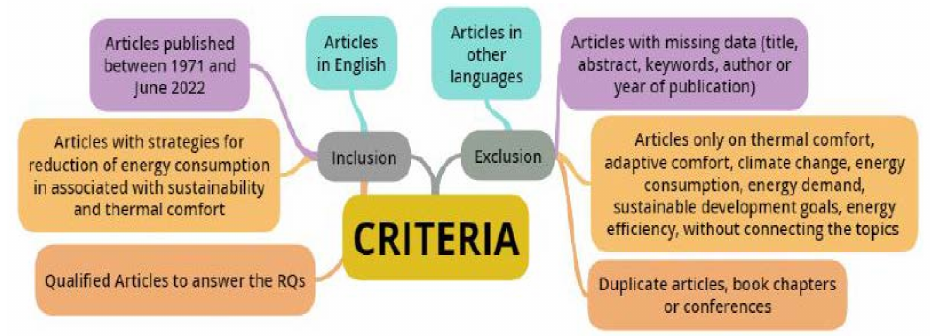
Figure 1. Inclusion and exclusion criteria used in the selection of the